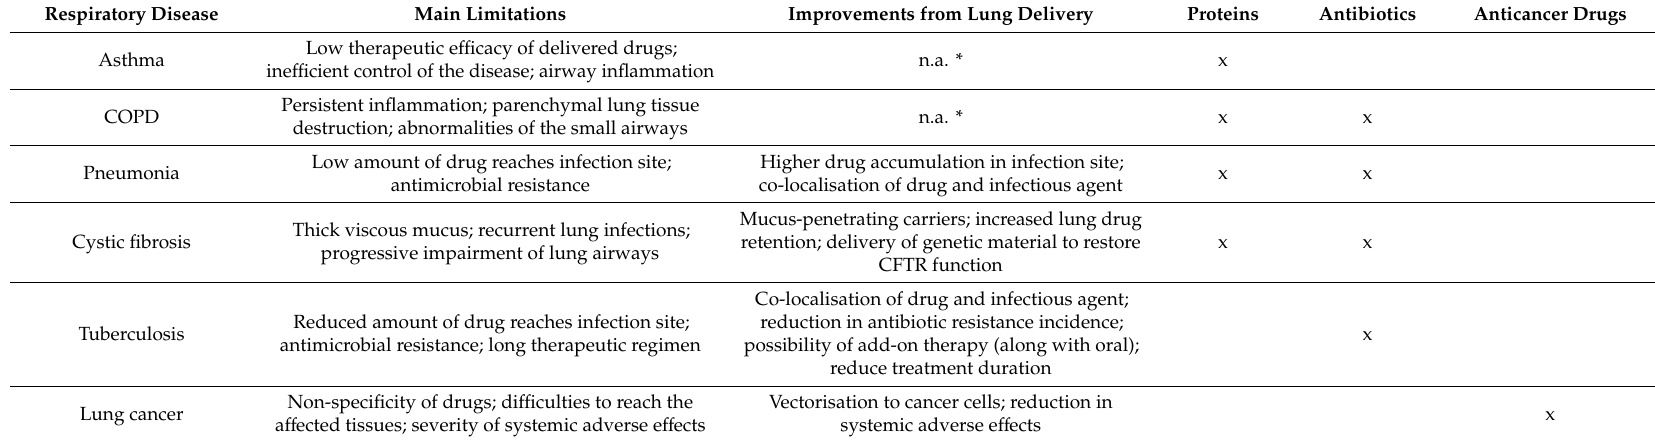
Table 1. General overview of the major respiratory diseases, along with their main limitations and improvements imparted by pulmonary delivery of the drugs. Indication of the application, in each disease, of the drug classes addressed in the